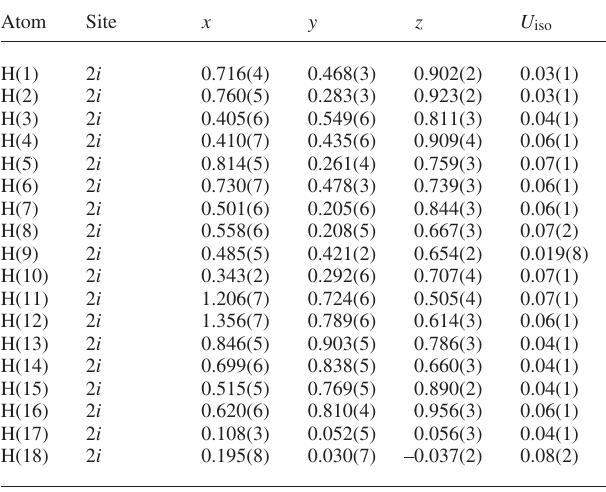
Table 2. Atomic coordinates and displacement parameters (in Å 2 )